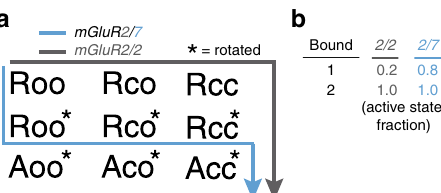
Fig. 8 State diagram model of activation pathway. a The transition of an mGluR from the resting state (Roo) to the active state (Acc) involves transition of the two LBDs from the open state (o) to the closed state (o), and rotation (*) of the LBDs relative to one another. In absence of agonist, mGluR2/2 is stable in Roo, and previous work has shown that the main route of activation is Roo → Roc → Rcc → Rcc*, although a small amount of activation is possible from Roc. In contrast, we fi nd that mGluR2/7 spontaneously enters a partially activated (functionally inactive) conformation when both LBDs are held open by antagonist, which we propose as Roo → Roo*. b The energetic difference results in much higher occupancy of the fully active state in mGluR2/7 in which only one subunit is liganded by